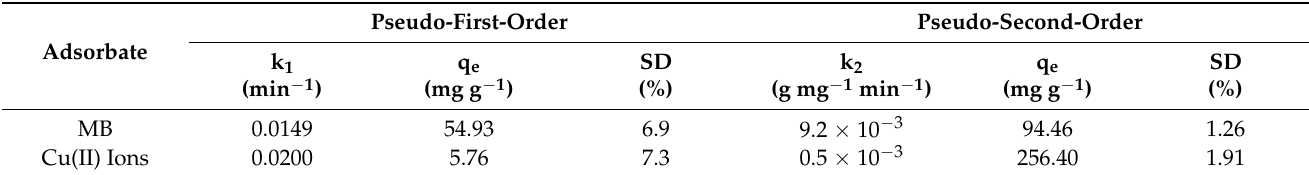
Figure 7. ( a ) Pseudo-second-order kinetic model and ( b ) pseudo-first-order kinetic model for MB and Cu (II) ions ad- sorption on the HGC-2 beads. Experimental conditions: 100 mg of dried HGC-2 beads, 100 mL solution, pH 8.0 (MB) or pH 5.0 (Cu(II) ions) under room temperature. Table 3. Kinetic parameters in the adsorption of MB and Cu(II) ions onto the HGC-2 sample. Pseudo-First-Order Adsorbate